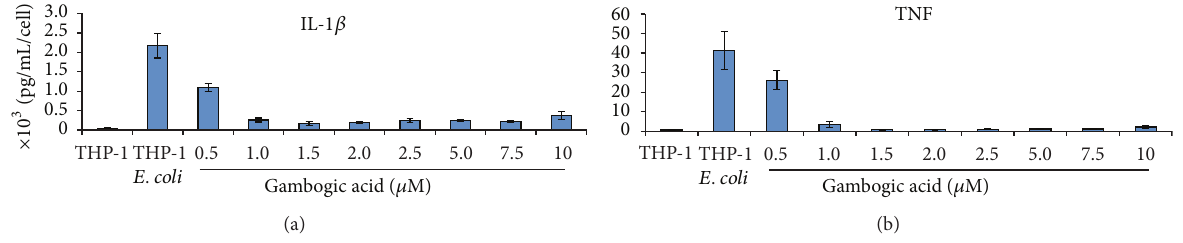
Figure 1: IL-1 𝛽 and TNF secretion are inhibited by gambogic acid treatment. Media samples from human THP-1 macrophage-like cell line cultured with growing concentrations of gambogic acid were analyzed by ELISA technique. Differences were considered statistically significant for 𝑃 values <